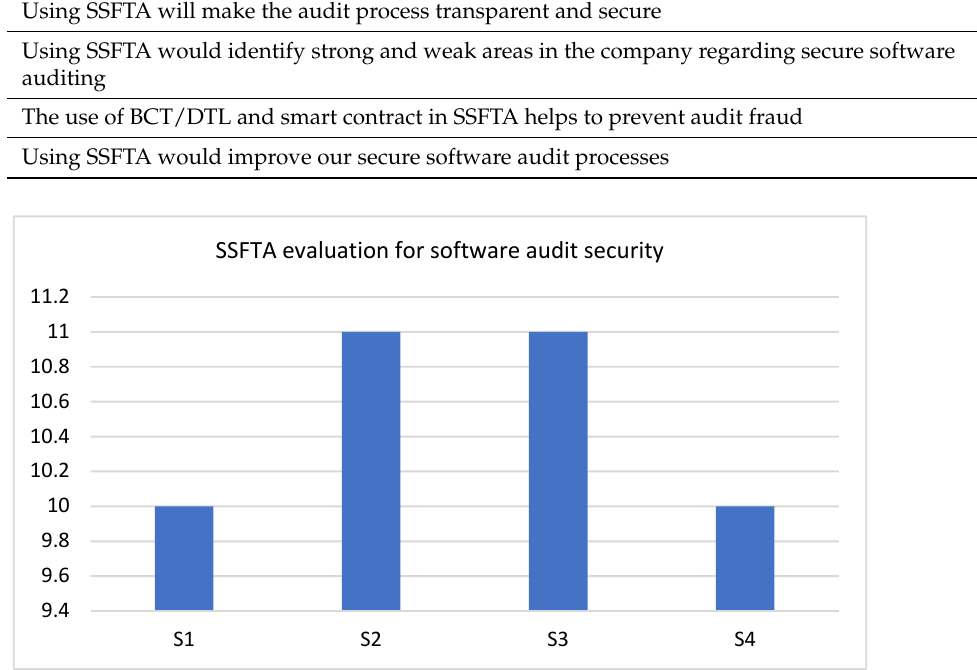
Figure 5. SSFTA evaluation for the security of software audit. Table 5. The questions to evaluate the SSFTA structure.